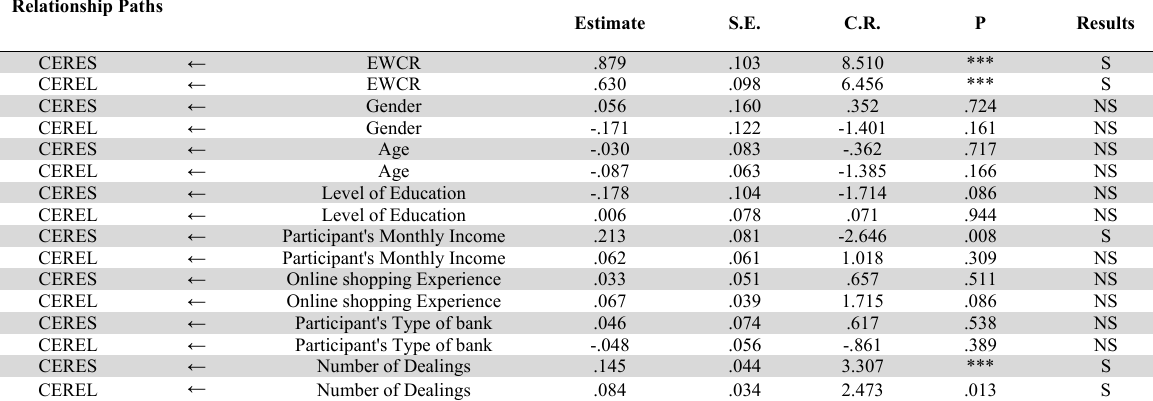
Regression Paths Weights: (Default model-Group1) Relationship